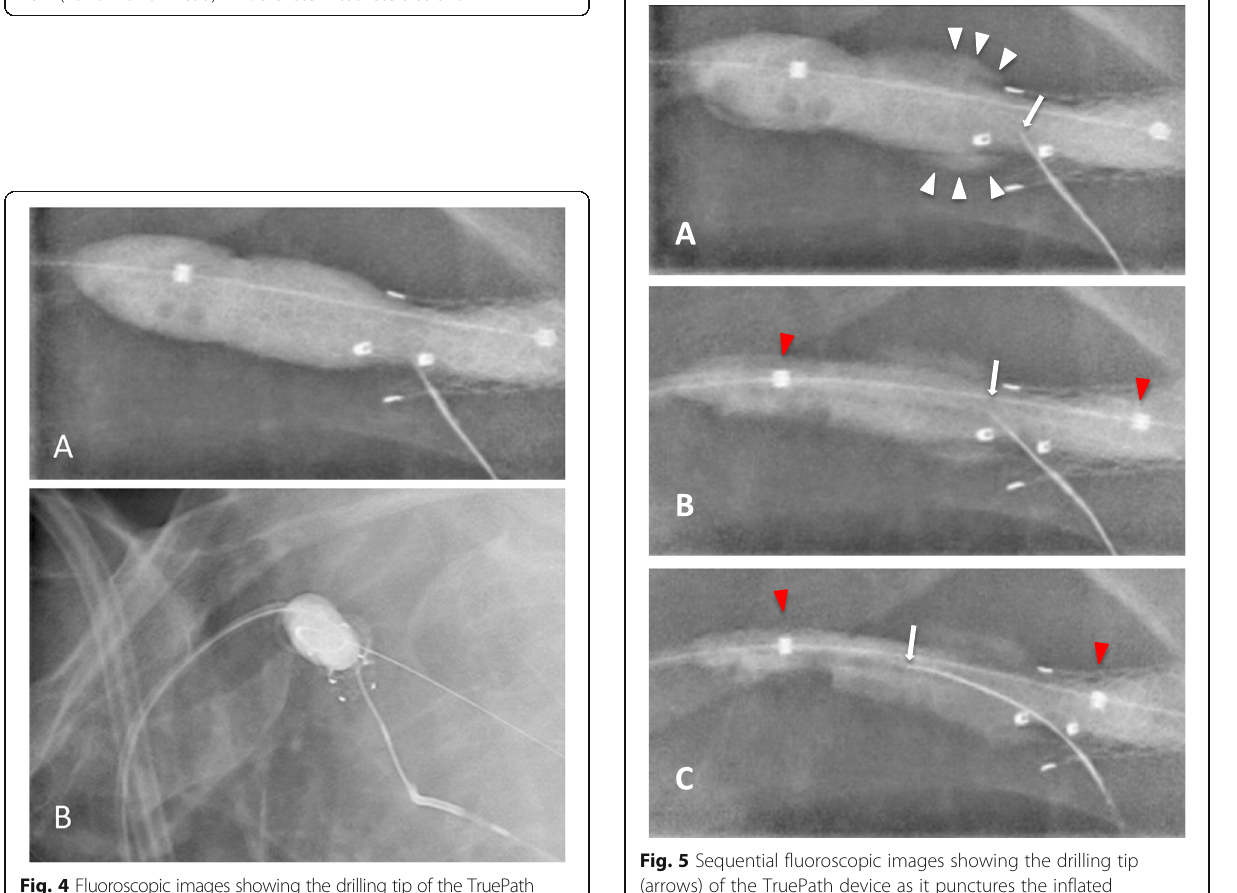
Fig. 3 Fluoroscopic image of the occluded left cephalic stent graft, which was accessed with a 21G micropuncture needle under ultrasound guidance. The tip of the needle (arrow) within the occluded stent lumen, with a V18 wire directed centrally. Tips of the antegrade axillary vein (broad arrowhead) and retrograde subclavian vein (narrow arrowhead) 4F Berenstein catheters as shown